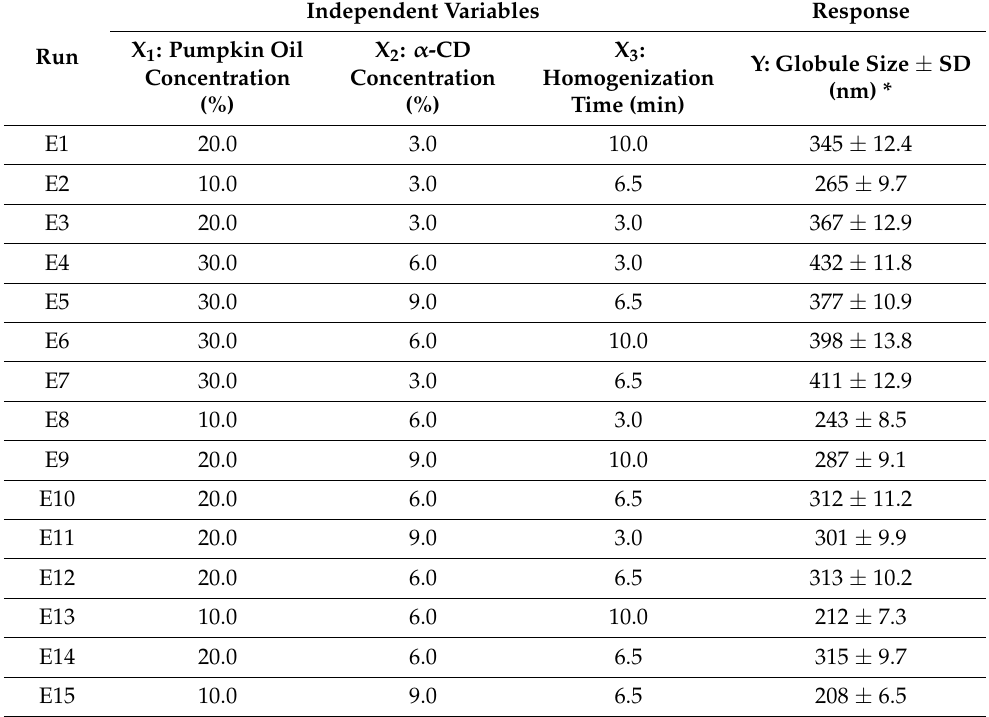
Table 2. Box–Behnken experimental runs of CTD-loaded GNE and their corresponding globule sizes. Independent Variables Response X 3 : X 2 : α -CD X 1 : Pumpkin Oil Run Y: Globule Size ± SD Homogenization Concentration Concentration (nm) Time (min) (%) (%)